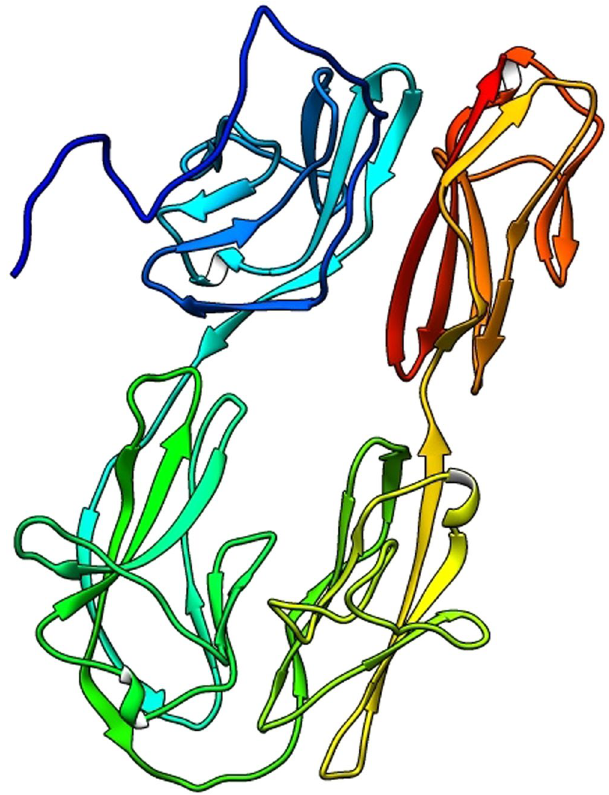
Figure 3. Final 3D model of hemolin protein after homology modeling and